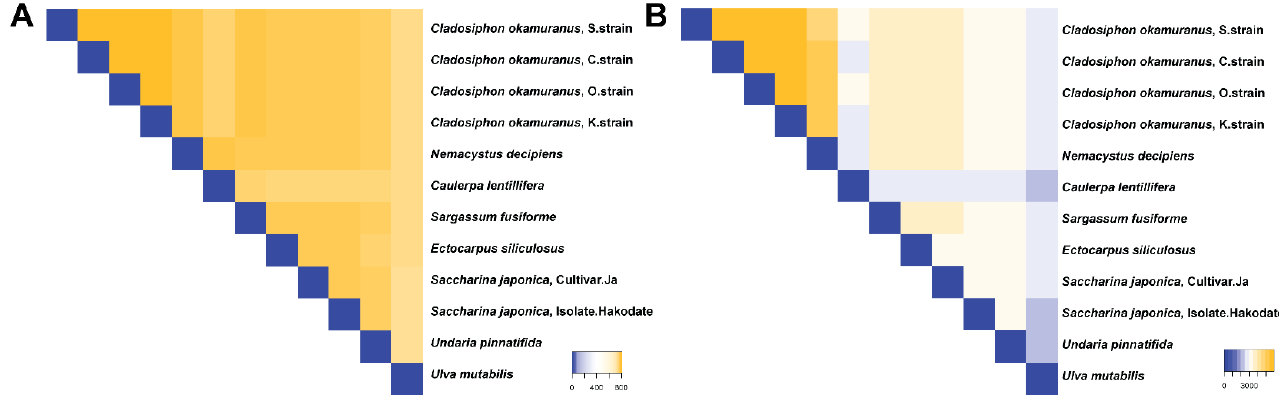
Figure 4. Summary of overlapping features among the 12 seaweed putative interactomes based on ( A ) cancer-related genes and ( B ) Pfam protein domains.